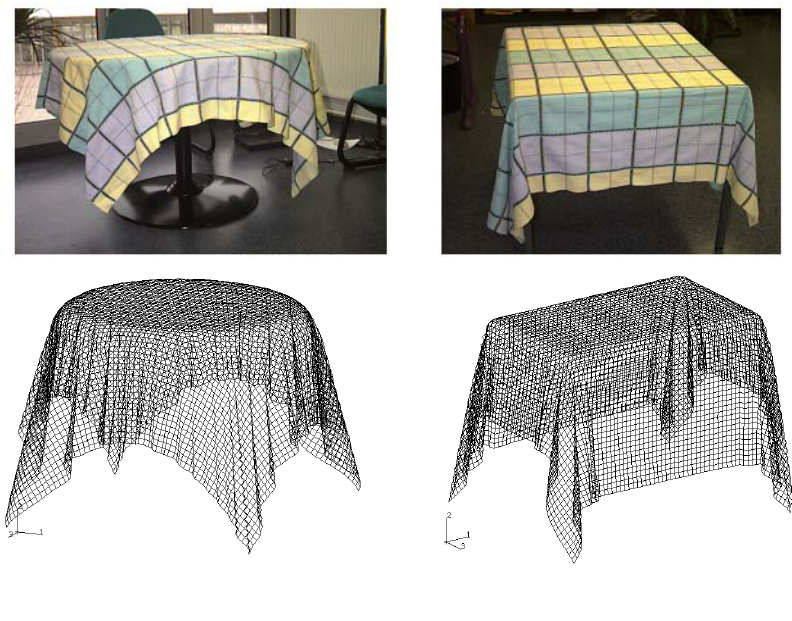
Figure 19. Experimental and numerical laying-up results of 3D textile